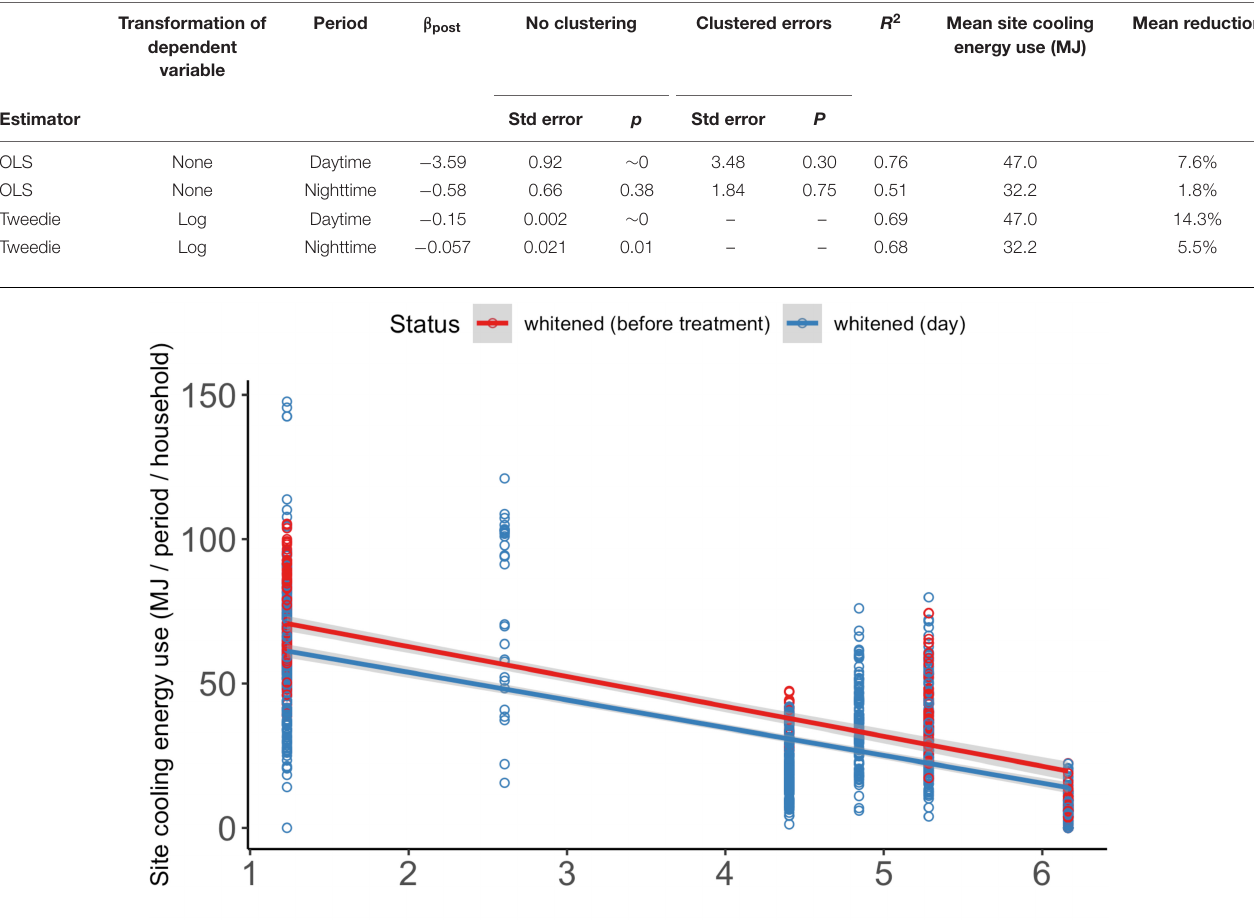
TABLE 5 | Regression results for applying Eq. 2 to the sample.